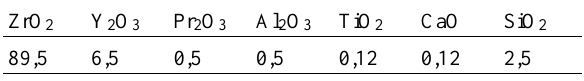
Table 1. Chemical compositions of the samples (mol%).